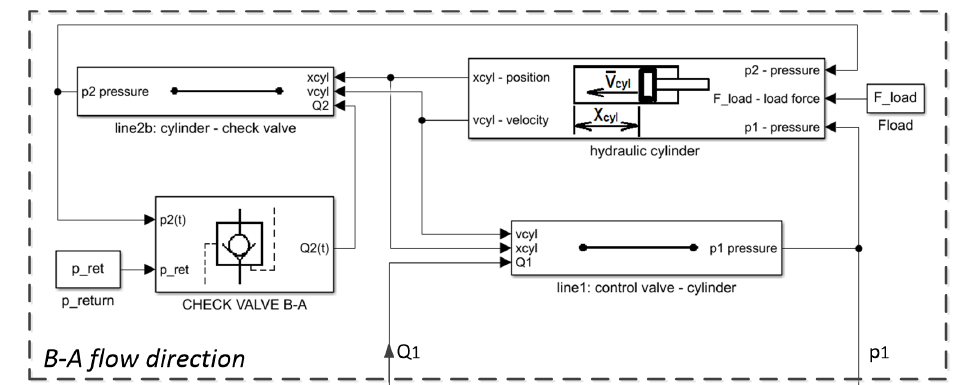
Figure 9. Difference in the simulation model for the B-A flow direction.